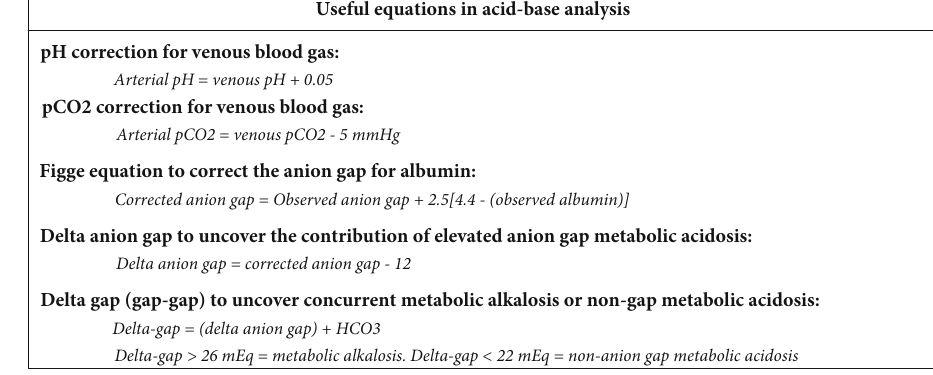
Figure 1: Useful equations for the evaluation of metabolic